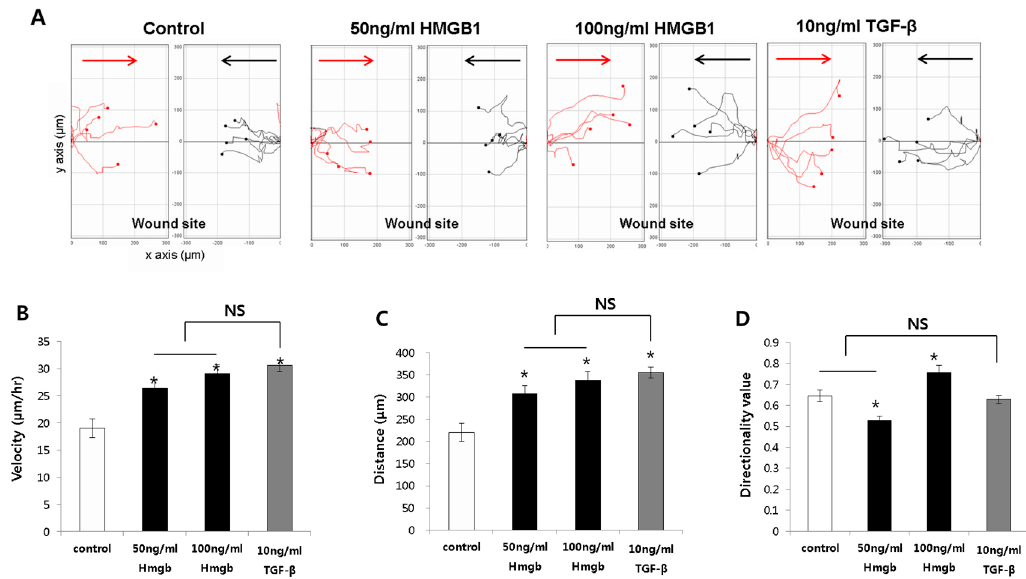
Figure 2. The cell tracking system for fibroblast migration was analyzed using cells selected from both sides of the wound, cells were tracked toward the site of wound insert after cultivation for 24 h; black, cells toward the midline from the left edge; red, cells toward the midline from the right edge ( A ); The average migration speed ( B ) and average accumulated distance ( C ) traveled after treatment with HMGB1 or TGF- β ; ( D ) Directionality values in response to HMGB1 or TGF- β treatment. All results are shown as mean ± SD (* p < 0.05).